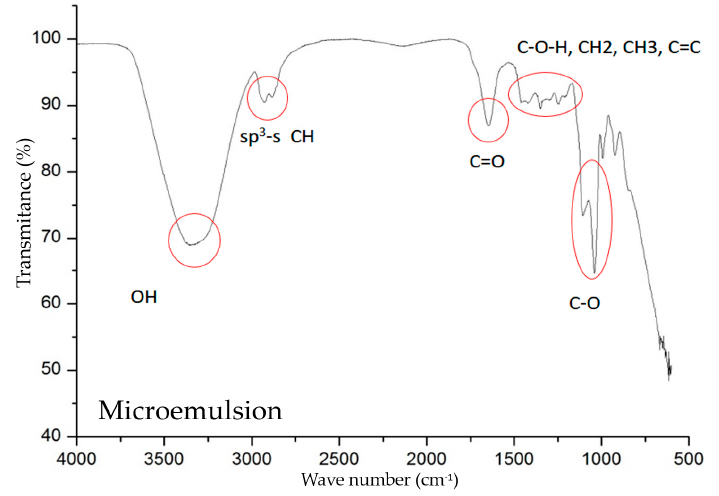
Figure 12. Absorption spectrum in the infrared region of the microemulsion. The infrared spectrum of the EDF drilling fluid, composed of the microemulsion with additives, was very similar to the spectrum of the pure microemulsion, with two signals referring to the C ‐ OH stretching of a primary and secondary alcohol, at 1082 cm − 1 and 1039 cm − 1 , overlapping bands in the region from 1460 cm − 1 to 1250 cm − 1 referring to C ‐ OH ab ‐ sorptions, CH 2 deformation, methyl, and C=C stretching, a signal at 1640 cm − 1 referring to carbonyl (C=O) ester, sp 3 ‐ s stretching of aliphatic CH at 2923 cm − 1 (asymmetric) and 2962 cm − 1 (symmetrical), and stretching of OH at 3361 cm − 1 (Figure 13).